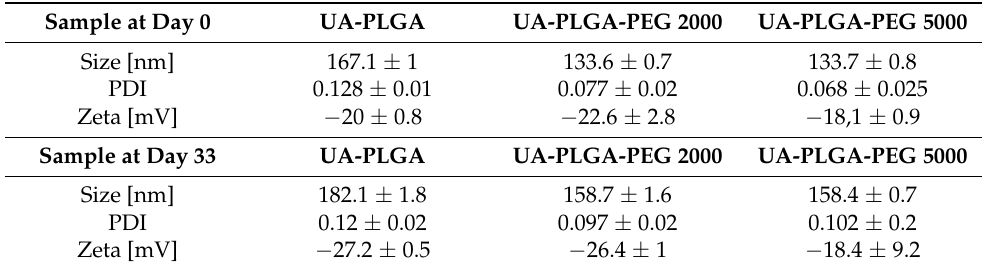
Table 3. Preliminary stability results for the tested nanoformulations.